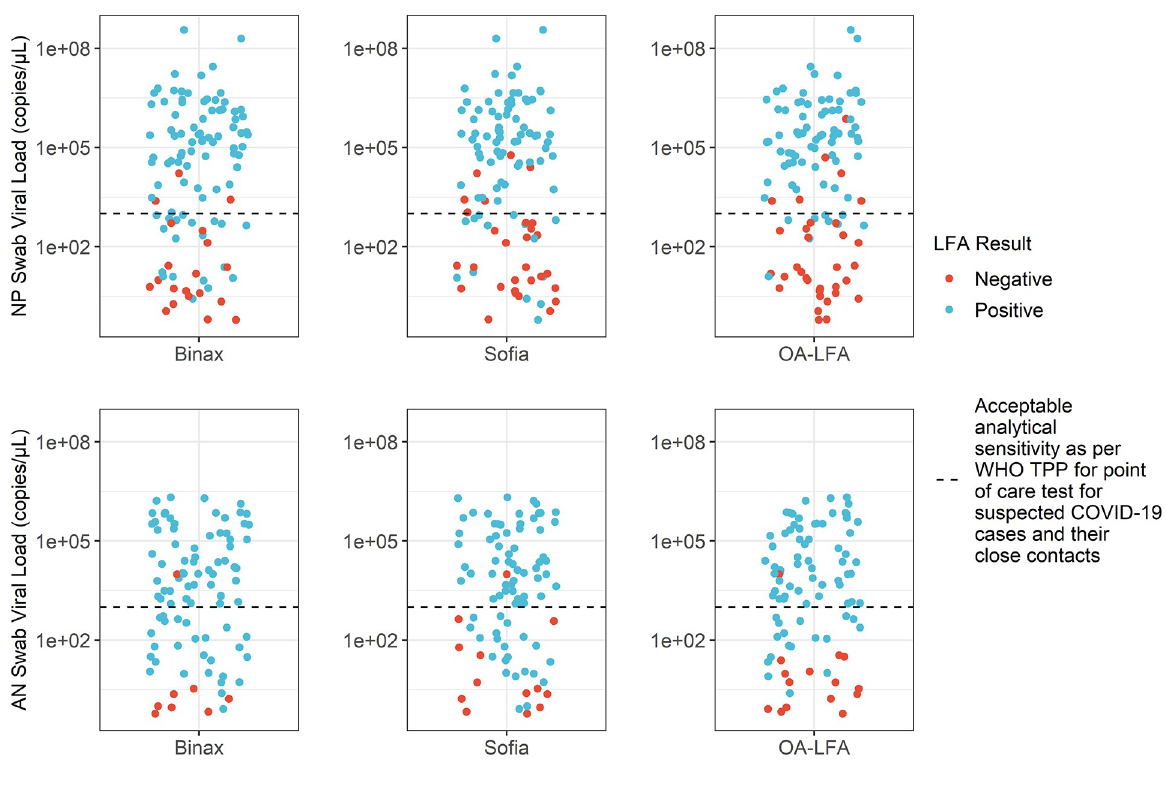
Fig 3. Test results as a function of NP (top) and AN (bottom) PCR positive tests. All tests perform well above the WHO TPP analytical sensitivity target of 10 3 copies/ μ L.